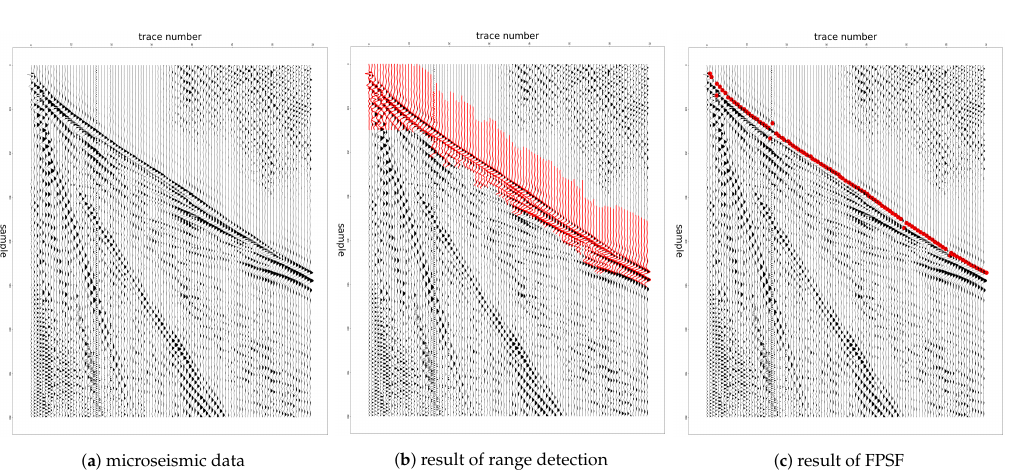
Figure 3. First arrivals picked by FPSF for field microseismic record. ( a ) field microseismic record; ( b ) the result of range detection; ( c ) the result of